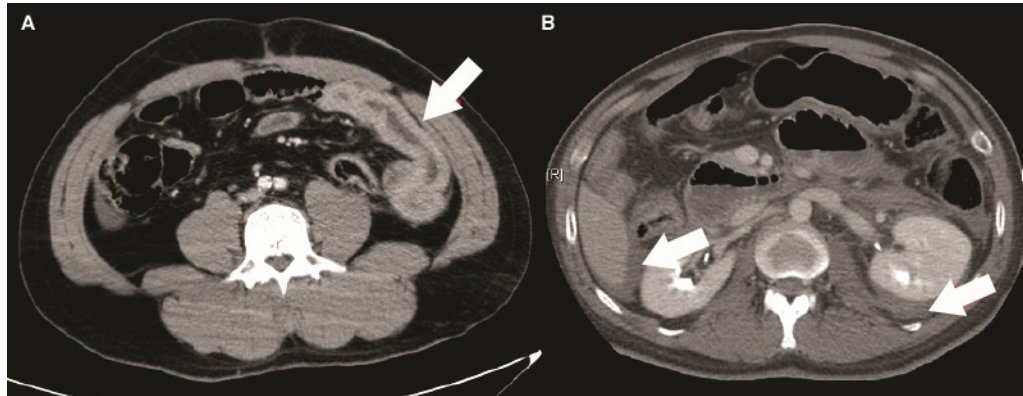
Figure 1. ( A ) The axial computed tomography presented multiple extraluminal air (arrows). ( B ) The abdominal computed tomography revealed a small extraluminal air bubble with focal fluid (arrowhead).